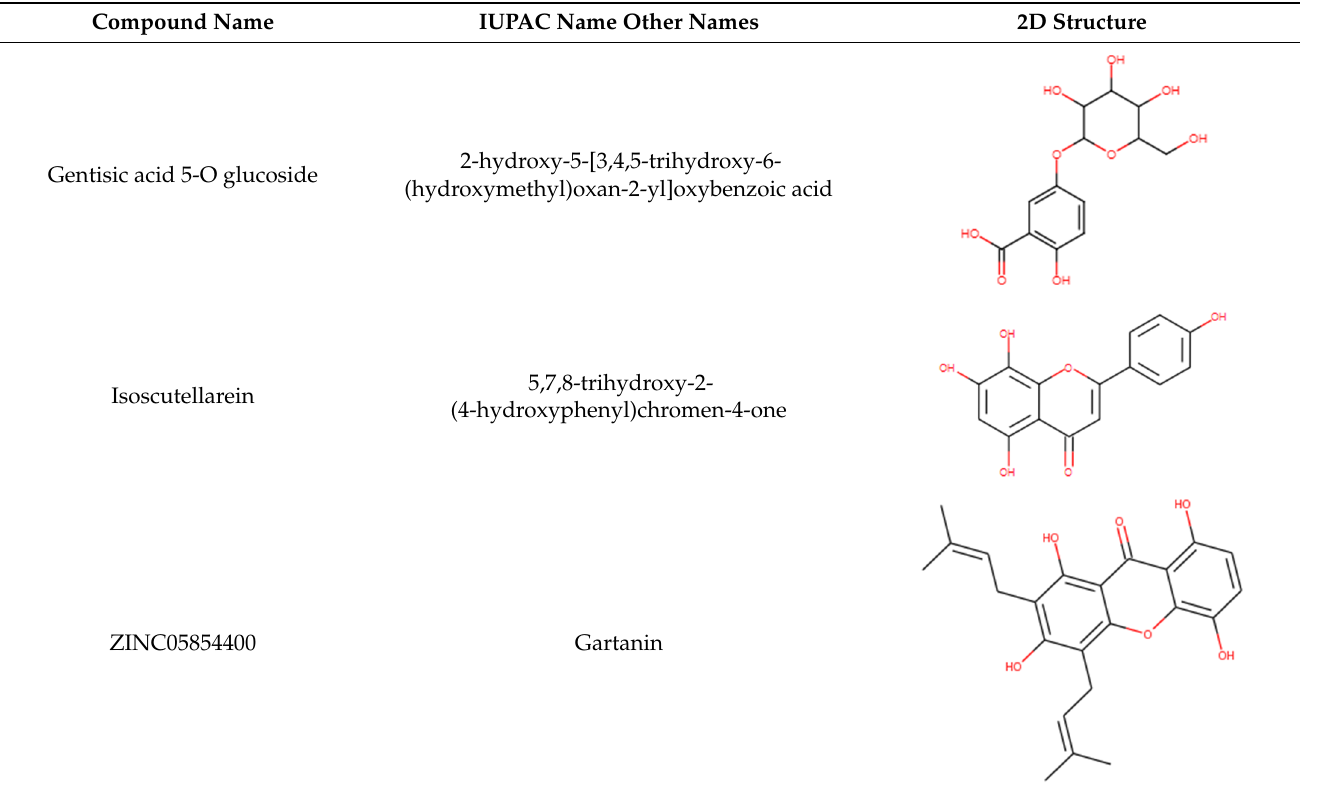
Table 7. Molecules with their names and 2D structures. The molecules have been suggested as potential antimycobacterial leads.